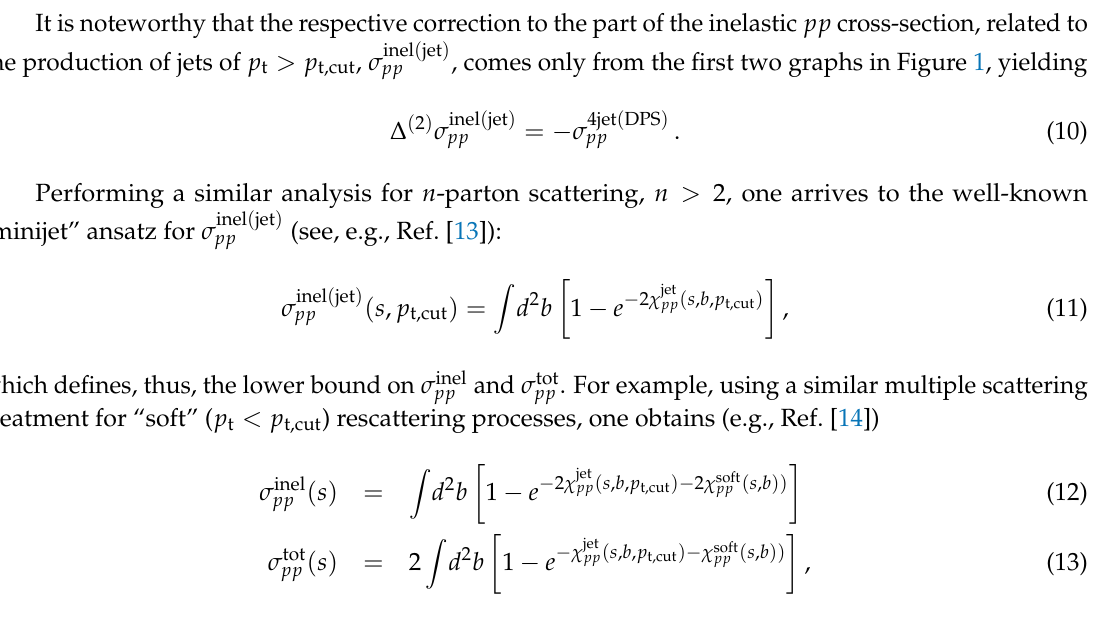
Figure 1. Schematic diagrams for different processes generated by double parton scattering in proton-proton collisions: double-dijet production ( left ), screening correction to single-dijet production ( middle ), and (quasi)elastic scattering ( right ); the vertical dashed-dotted lines indicate the position of the cut plane. Relative weights of the corresponding contributions are shown below the